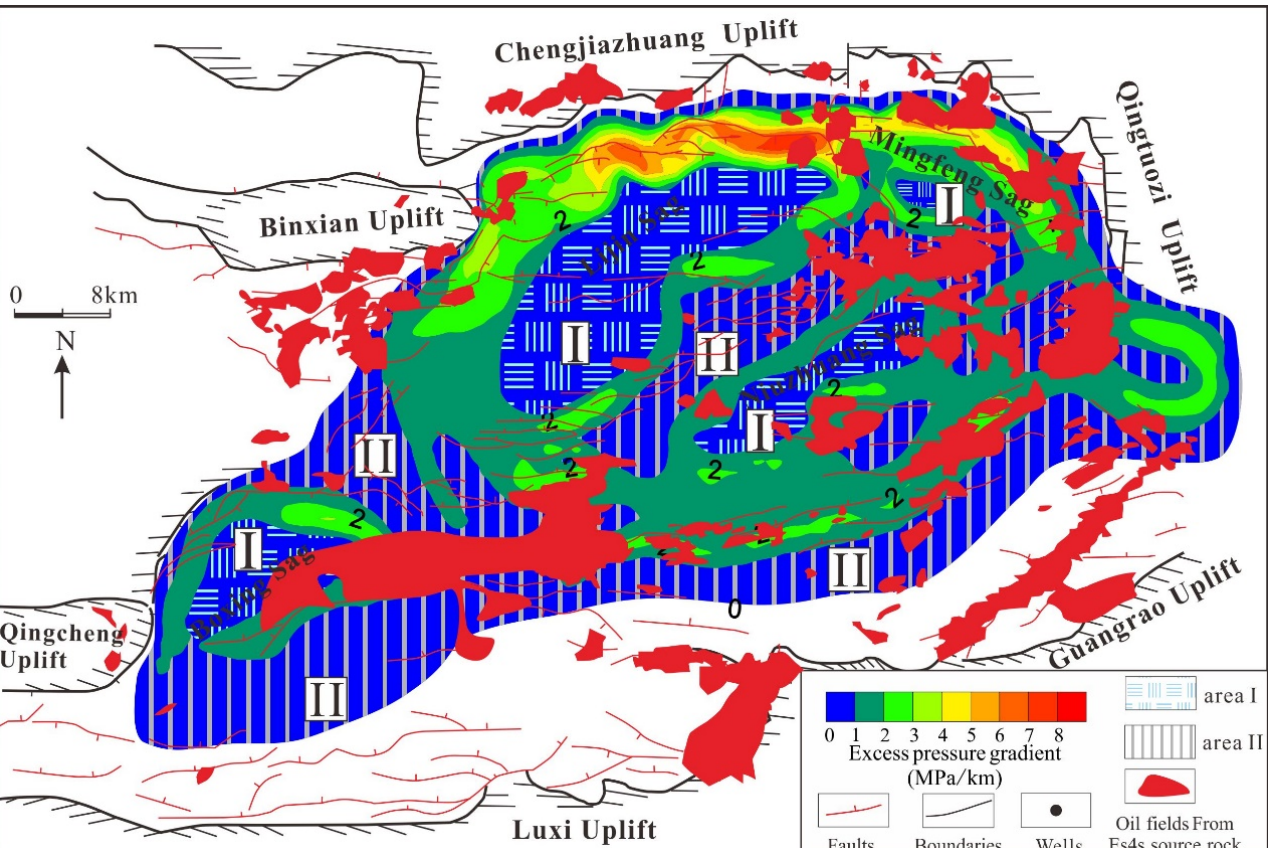
Figure 12. Superposition graph of excess pressure gradient in the upper interval of Es4 member and the plane distribution of oil fields related to the source of Es4 member and the mixed source of Dongying Depression.